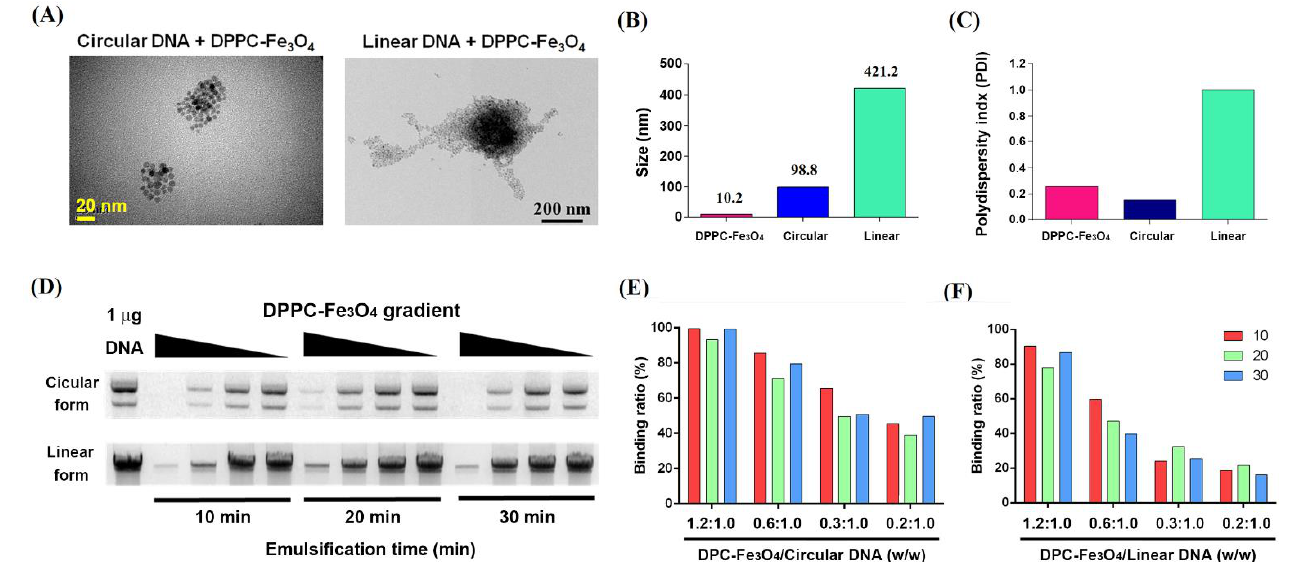
Figure 2. Characteristics of DPPC-Fe 3 O 4 nanoparticle binding with circular or linear plasmid DNA. ( A ) Transmission electron microscopy (TEM) examination of the nanoparticle morphology of DPPC-Fe 3 O 4 binding with circular plasmid DNA (right; scale bar = 20 nm) and linear plasmid DNA (left; scale bar = 200 nm). ( B ) Dynamic light scattering (DLS) analysis of the nanoparticle sizes of DPPC-Fe 3 O 4 alone, DPPC-Fe 3 O 4 binding with circular plasmid, and DPPC-Fe 3 O 4 binding with linear plasmid DNA. ( C ) DLS analysis of the polydispersity index (PDI) value of DPPC-Fe 3 O 4 alone, DPPC-Fe 3 O 4 binding with circular plasmid, and DPPC-Fe 3 O 4 binding with linear plasmid DNA. ( D ) Electrophoretic gel mobility shift assay (EMSA) of different emulsification times and concentrations of DPPC-Fe 3 O 4 (1273.6 ng, 636.8 ng, 318.4 ng, and 212.3 ng) binding with 1000 ng circular or linear plasmids. The DPPC-Fe 3 O 4 /DNA ratios ( w / w ) were defined as 1.2:1.0, 0.6:1.0, 0.3:1.0, and 0.2:1.0, respectively. Semiquantitative analysis of the binding ability (×100%) of DPPC-Fe 3 O 4 with circular plasmid DNA ( E ) or linear plasmid DNA ( F ).